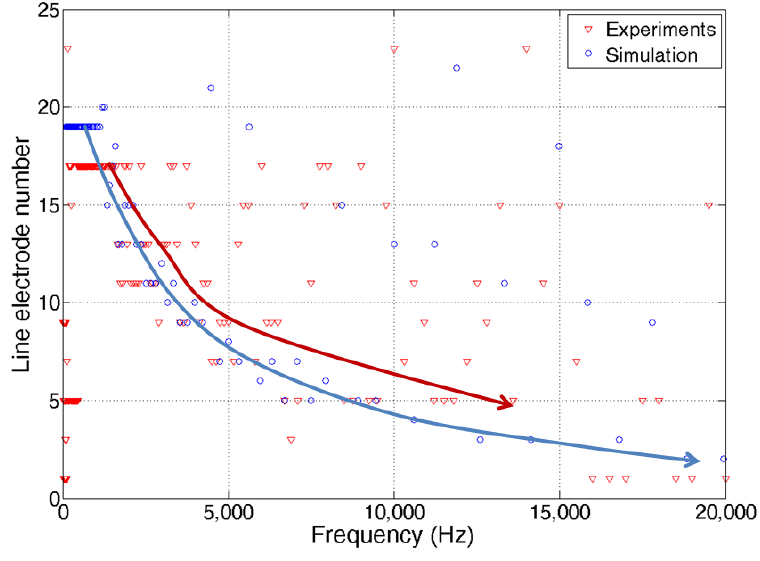
Figure 11. Frequency separation of the McPAS device in the piezoelectric